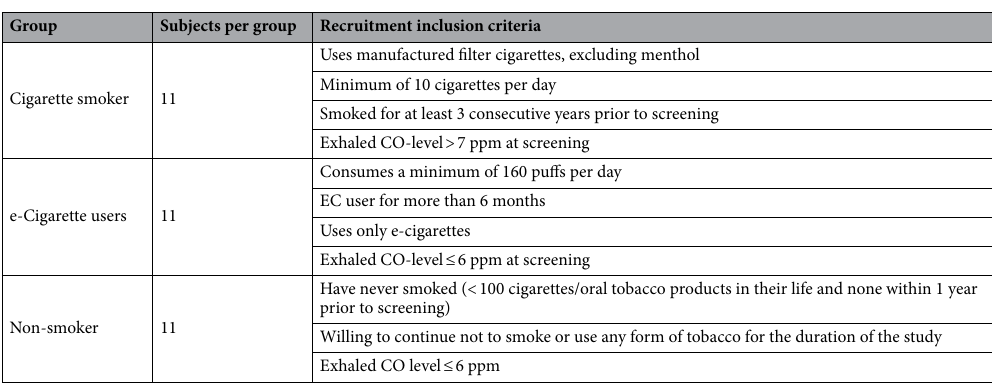
Figure 1. Overview of breath assessment method.